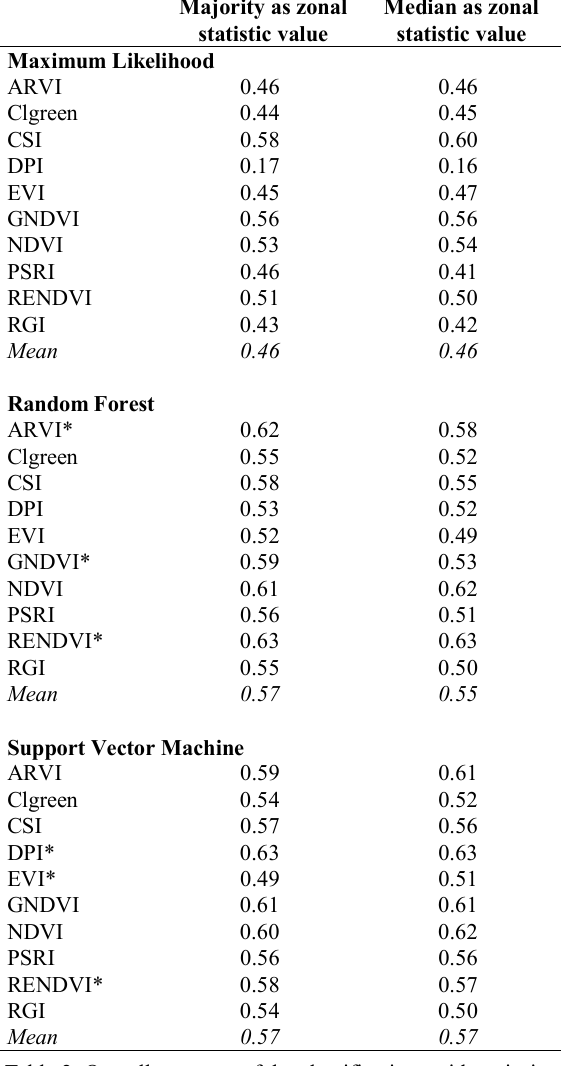
Table 2. Overall accuracy of the classifications with majority and median as zonal statistic value for all VIs and classifiers using the ATCOR-corrected image. * Maps of these VIs are shown in Figure 2.